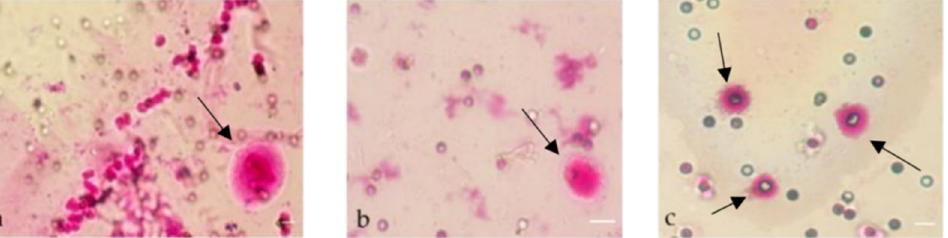
Figure 5. CTCs stained with MGG present in blood samples of PCa patients: ( a , b ) Patient #7 current treatment enzalutamide after docetaxel chemotherapy with a PSA level of 105 ng/mL. ( c ) Patient #5 current treatment docetaxel chemotherapy with a PSA level of 5.2 ng/mL. Scale bares indicate 20 µm. Arrows indicate CTCs.